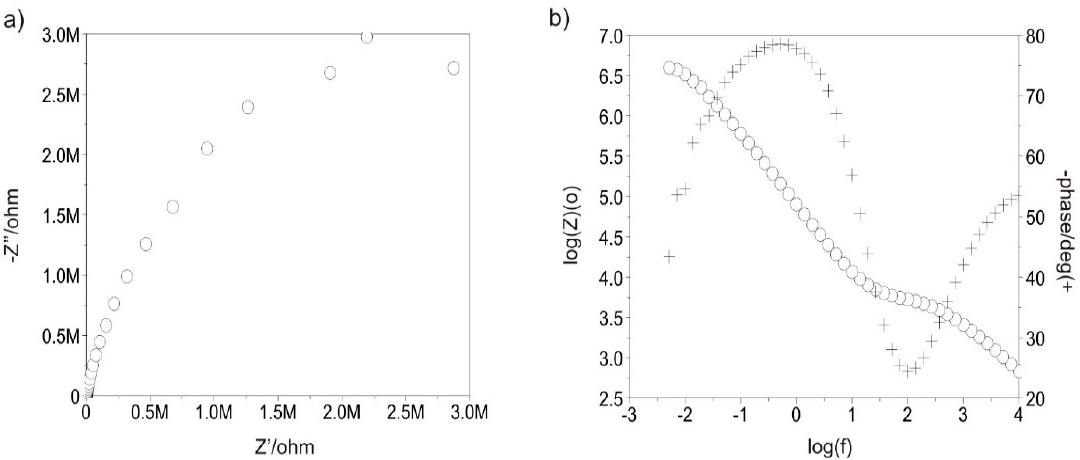
Figure 12. Sand-blasted sample with the DLC coating: ( a ) Nyquist diagram and ( b ) Bode diagram. ◦ : log(Z); + : -phase / deg.